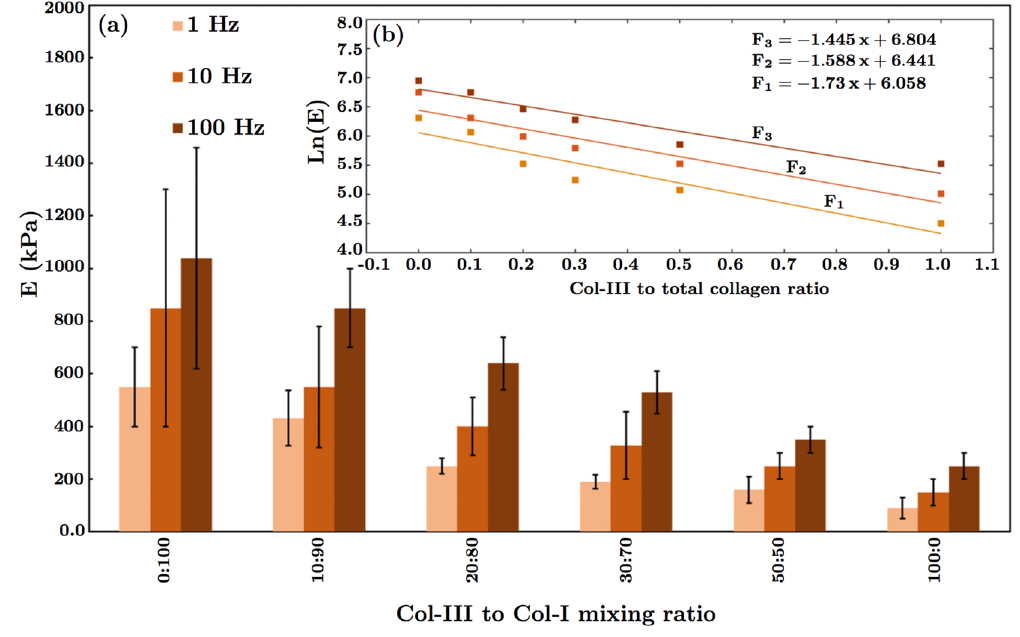
Figure 8. Measured dynamic elastic moduli of collagen fibrils for different loading rates (1–100 Hz). ( a ) Elastic moduli versus Col-III:Col-I mixing ratio expressed as the mean ± standard error. The differences were found to be statistically significant (p < 0.05); ( b ) The semi-logarithmic diagrams of the average elastic moduli versus Col-III:Col-I mixing ratios and the fitted curves. F 1, F 2, and F 3 denote the logarithmic function of the elastic modulus E at 1, 10, and 100 Hz, respectively. The elastic moduli obtained at 100 Hz were found to be greater than the ones obtained at 10 Hz. Similarly, the moduli obtained at 10 Hz were greater than the ones obtained at 1